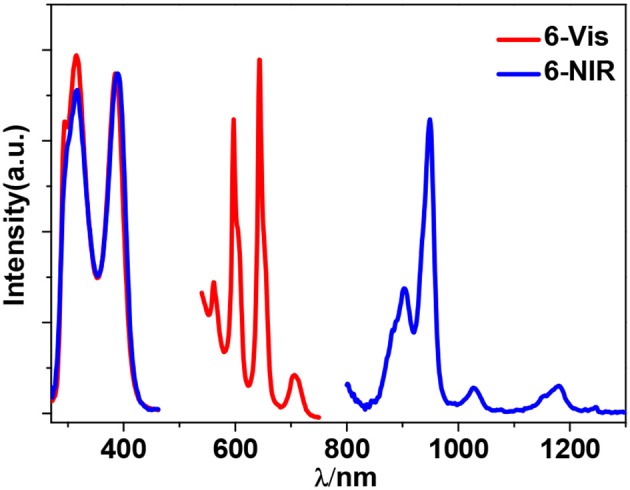
Excitation and emission spectra for 6 in CH3CN.